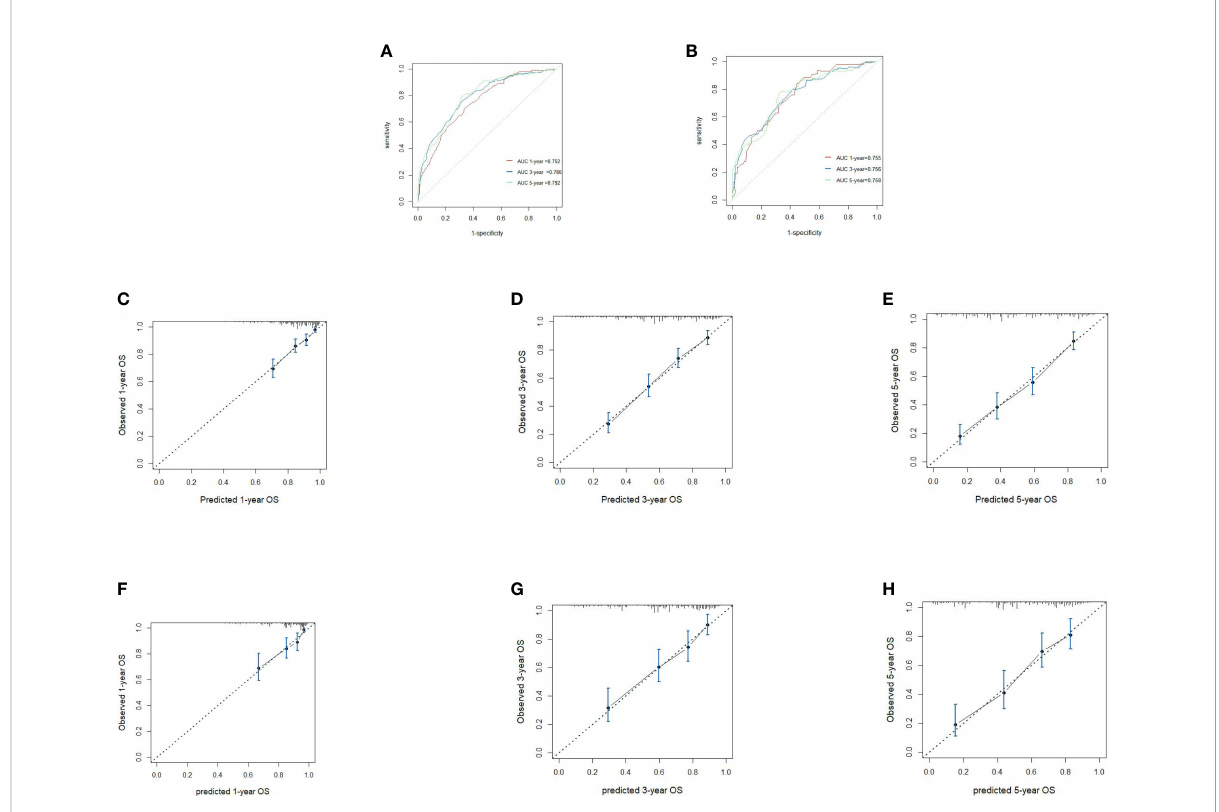
FIGURE 2 Receiver operating characteristics to describe the predictive power of the model in the training cohort (A) and the validation cohort (B) . Calibration curves of 1-year (C) , 3-year (D) and 5-year overall survival (OS) (E) for stage IIIC endometrial cancer patients with adjuvant radiotherapy alone in the training cohort. Calibration curves of 1-year (F) , 3-year (G) , and 5-year OS (H) in the validation